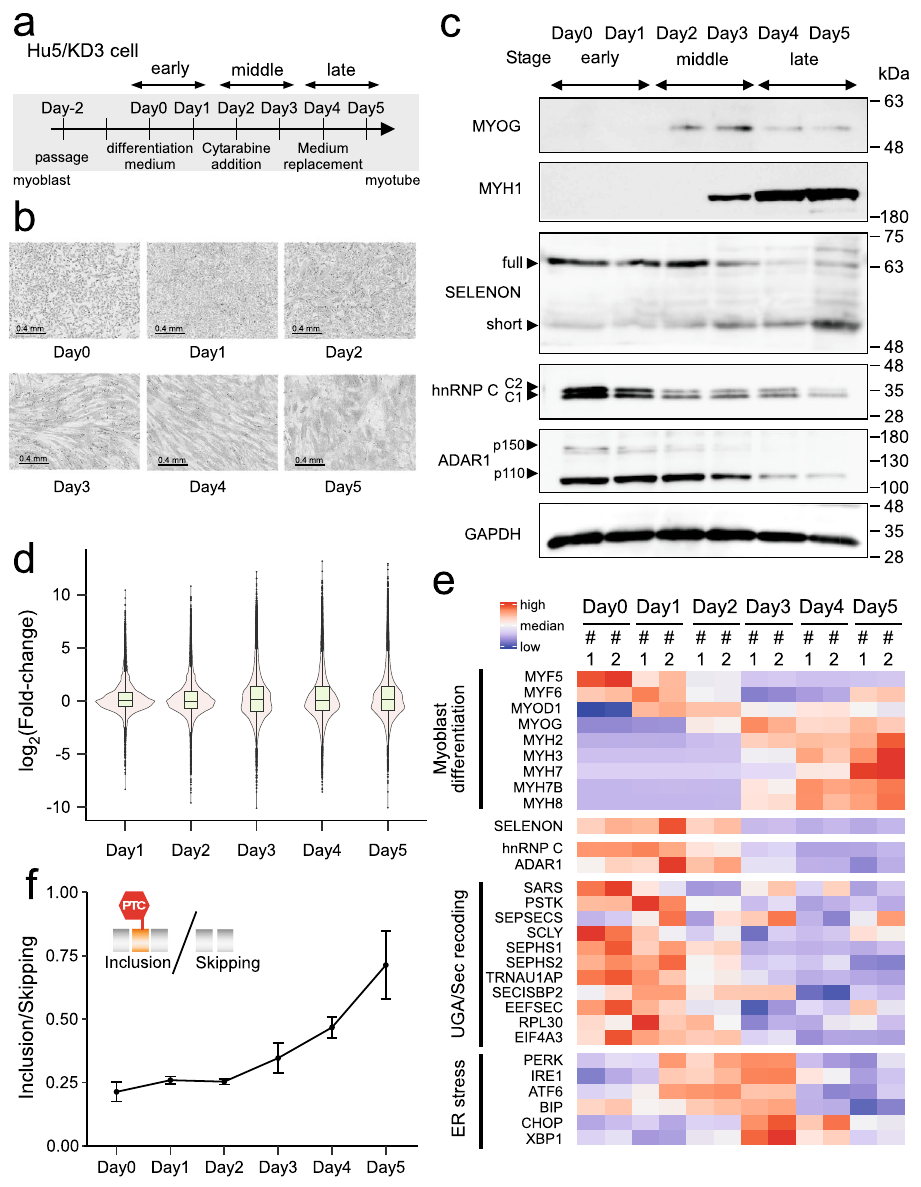
Fig. 2 Stage-speci fi c expression pro fi les and dynamic alteration of Alu exonization of SELENON during skeletal myogenesis of Hu5/KD3 cells. a Experimental schedule for differentiation of Hu5/KD3 cells. b Phase-contrast images showing Hu5/KD3 cell differentiation from Day 0 to 5. This experiment was repeated more than three times independently with similar results. c Expression analyses of the differentiation markers (MYOG, MYH1), SELENON, hnRNP C, ADAR1, and GAPDH (control) by western blotting on the indicated days during differentiation of Hu5/KD3 cells. SELENON (full- length and short isoforms), hnRNP C2 and hnRNP C1, and p150 and p110 isoforms of ADAR1, are indicated by arrowheads. The samples derived from the same experiment and the gels/blots were processed in parallel. This experiment was repeated more than three times independently with similar results. d Distribution of Log 2 (fold-change) of expressed genes in RNA-seq data in Hu5/KD3 cells on each day of differentiation relative to Day 0, shown as violin and box plots. For the box plot, center lines indicate median, box limits indicate upper and lower quartiles, whiskers indicate 1.5× interquartile range and points indicate outliers; n = 58,278 genes. e Heat map of RNA-seq transcriptome analysis of differentiation markers, SELENON, hnRNP C, ADAR1, UGA/ Sec recoding factors, and ER stress markers on the indicated days in differentiating Hu5/KD3 cells. Colors correspond to the per-gene z-score calculated from log 10 fragments per million (FPM) reads mapped. f RT-qPCR to estimate the Alu exonization level of SELENON mRNAs during myoblast differentiation. Transcripts of each isoform were quanti fi ed using Hu5/KD3 total RNA from each day of differentiation. The graph represents the ratio between the inclusion and skipping isoforms. Data are presented as mean values ±S.D.; n = 3 biologically independent samples. Source data and unprocessed gel images are provided in the Source Data fi